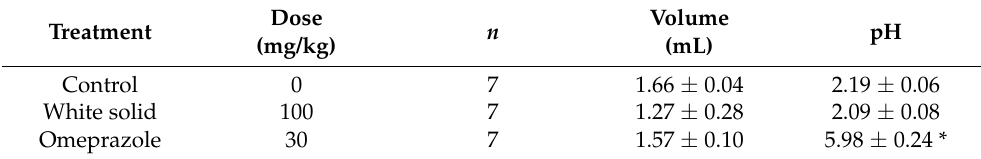
Table 3. Evaluation of the antisecretory activity of the white solid.